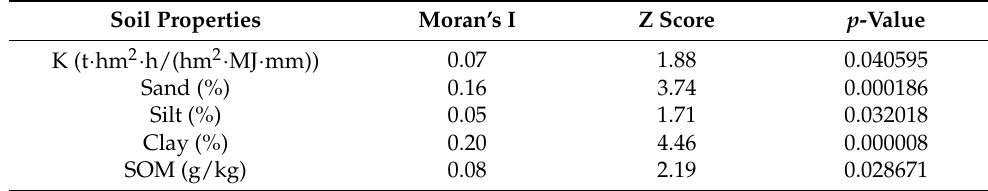
Table 3. Moran’s I index of basic soil properties and erodibility K values in the study area. Soil Properties